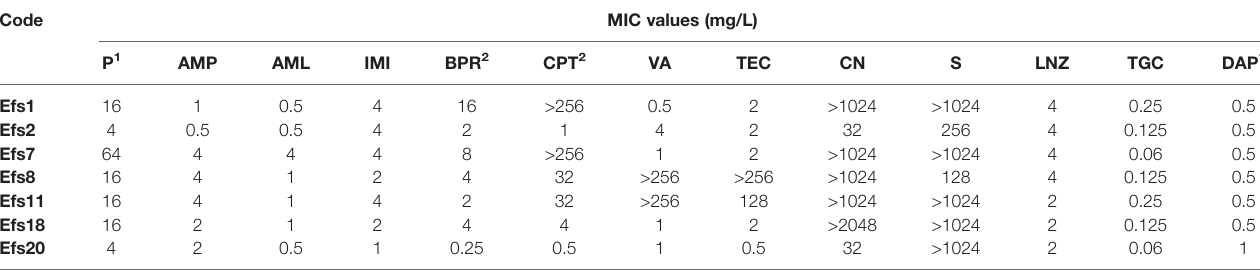
TABLE 1 | Beta-lactams and comparator antimicrobial MIC values against E. faecalis clinical